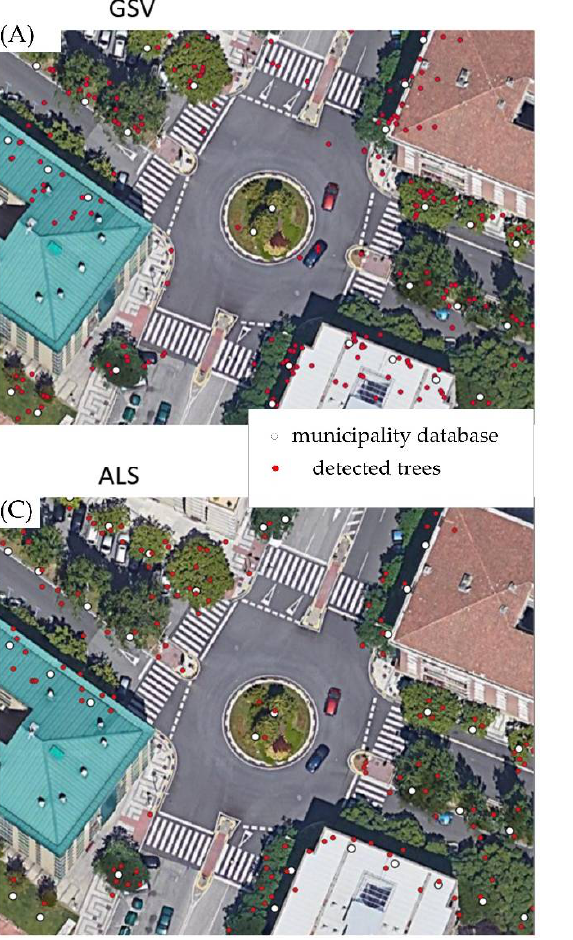
Figure 7. Example of the methodology in one of the areas of the city. ( A ) ITD through GSV imagery and ( C ) ITD through ALS. In this first stage, the white dots indicate the trees from the municipality’s database, while the red dots indicate the trees detected by the methodology. The images on the right show the combination of stages. ( B ) ITD through GSV and FP debugging through GSV, ( D ) ITD through ALS and FP debugging through ML. Green dots indicate well-identified trees (TPs) and red dots indicate incorrectly detected trees (FPs).